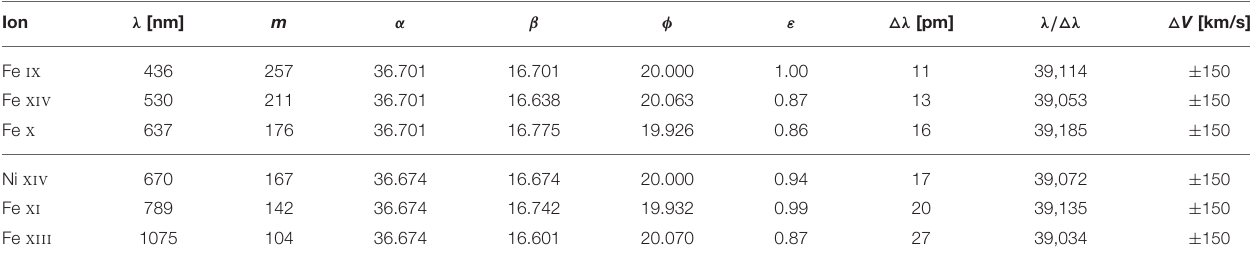
TABLE 1 | Instrument characteristics of the mxCSM